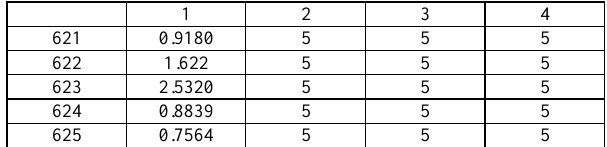
Table 1. Results of the mean absolute error of the neural network 5–5–5